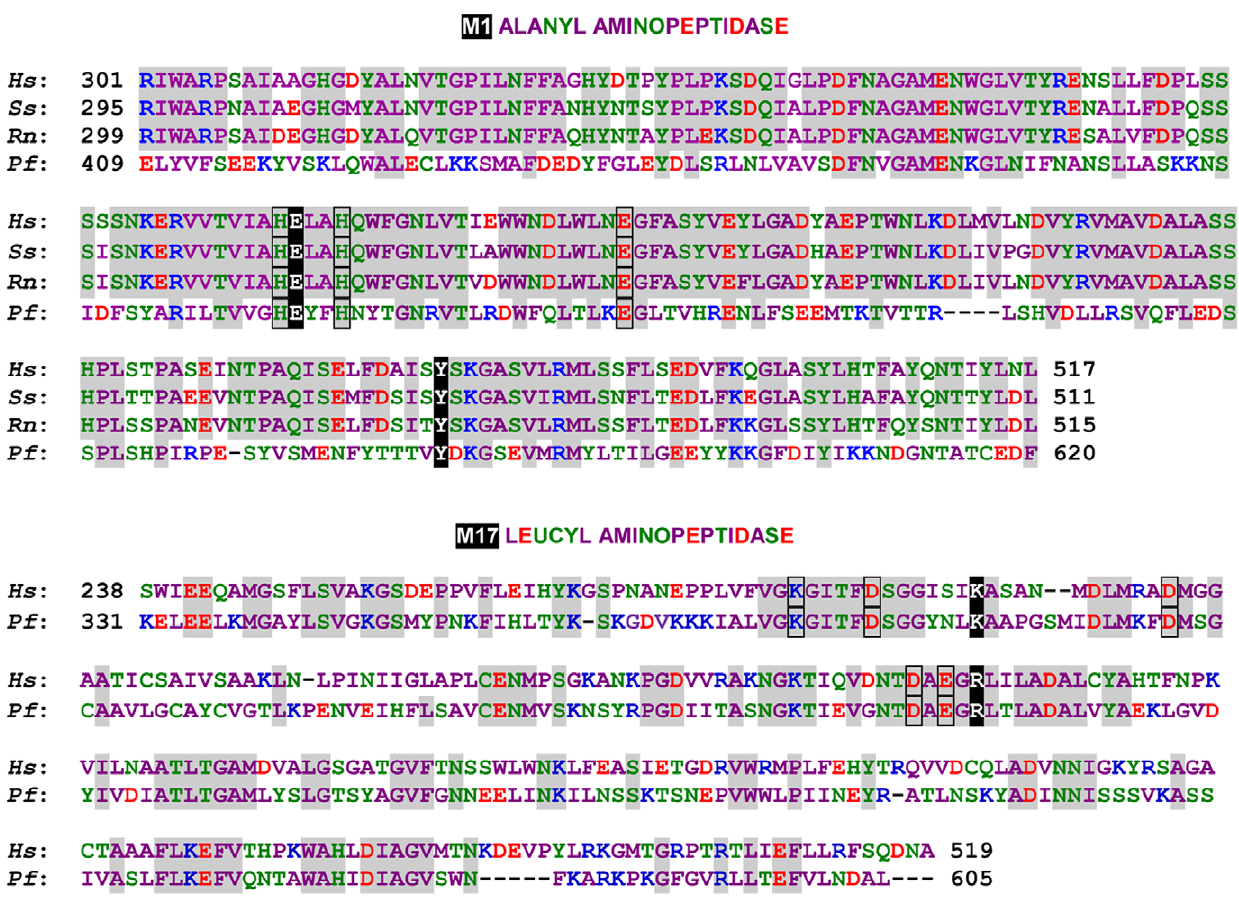
Figure 1. Multiple sequence alignments of Pf M1AAP and Pf M17LAP with mammalian orthologs, H: human Homosapiens , P: pig, Sus scrofa , R: rat, Rattusnorvegicus and X: Plasmodiumfalciparum . Dashes represent gaps that optimize sequence adjustment. Small or hydrophobic amino acids are colored in magenta, acidic are red, basic are blue and amino acids with an amine or hydroxyl group are green. Conserved amino acids are highlighted in gray. Amino acids from active side residues are presented on a black background and those participating in metal binding are outlined.